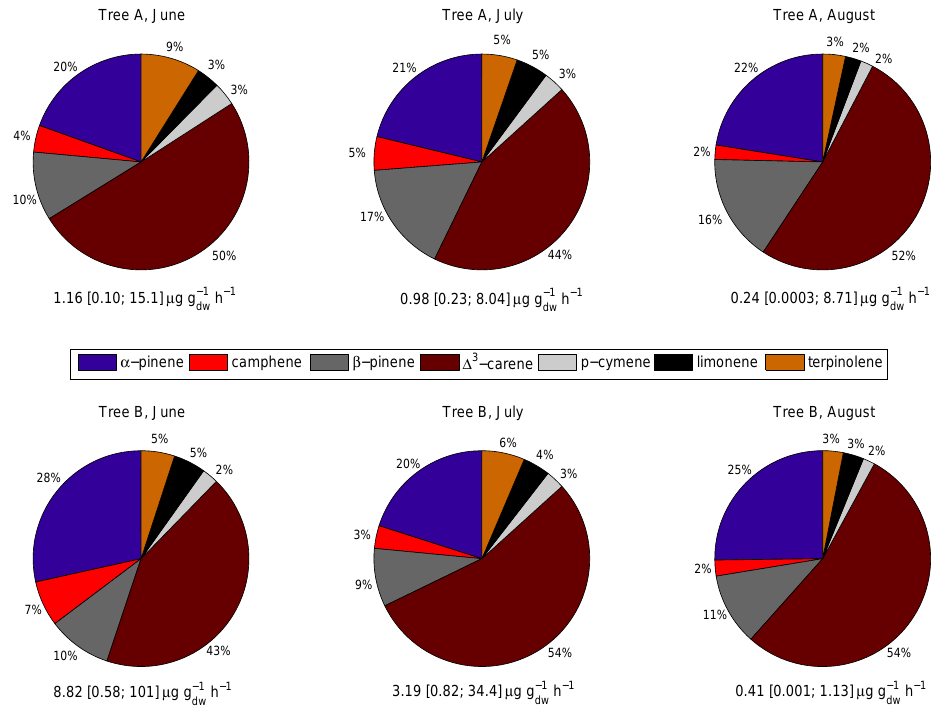
Fig. 3. Measured emission spectra of monoterpenes from the two Larix cajanderi trees during the measurement campaigns. Given below each pie chart are the monthly median and 5th and 95th percentile values of the total monoterpene emission rates.